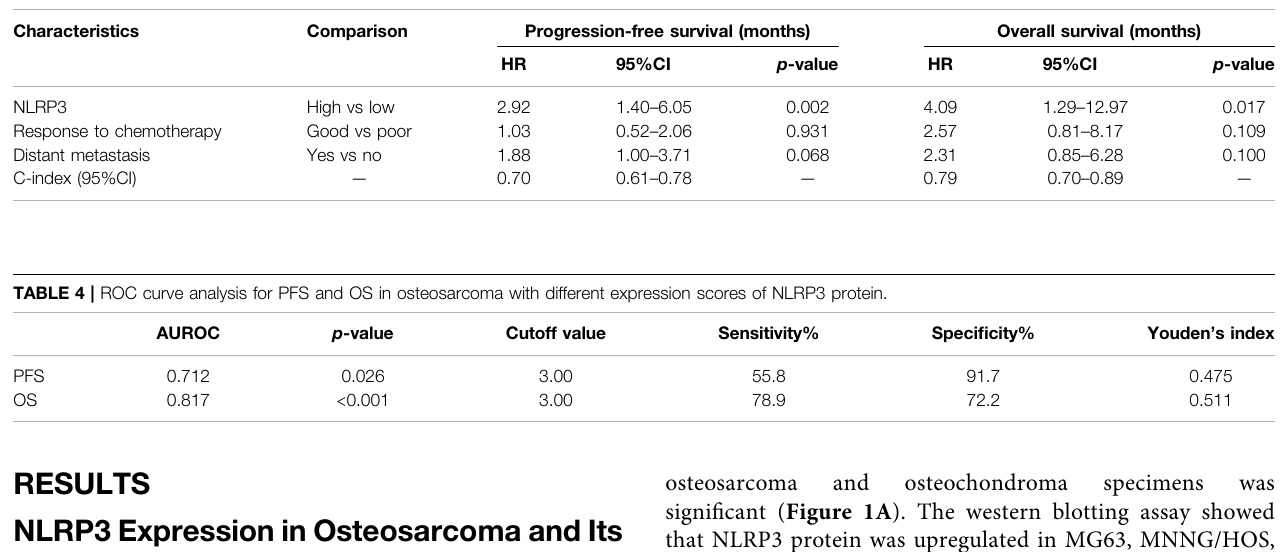
TABLE 3 | Multivariate analysis of NLRP3 expression and osteosarcoma patients survival. Characteristics